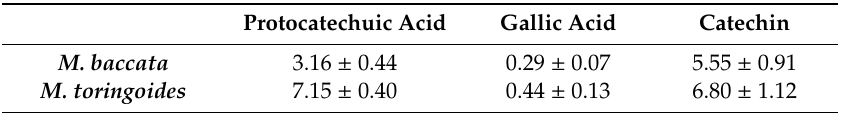
Table 1. The quantitative estimations of phenols in Malus baccata and Malus toringoides bark extracts (mg 100 g − 1 (dry weight) DW ± SD).